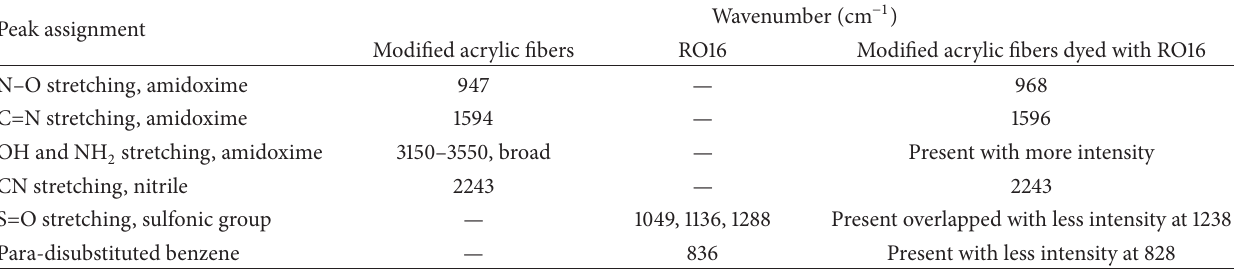
Table 3: FT-IR characteristic absorption peaks of modified acrylic fibers, RO16, and modified acrylic fabrics dyed with RO16.